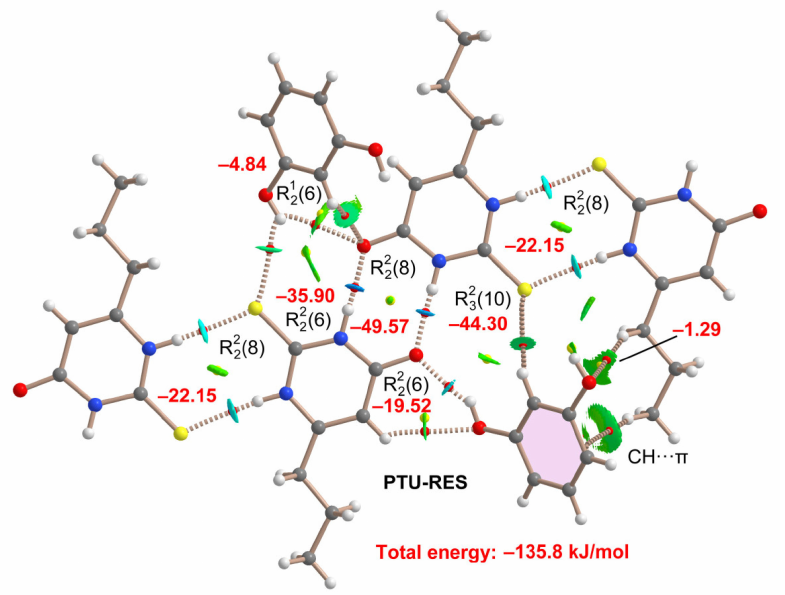
Figure 13. QTAIM/NCIPlot analysis of intermolecular bond and ring CPs (red and yellow spheres, respectively), bond paths, and RDG isosurfaces of the H-bonded assembly of PTU–RES cocrystal. The individual association energies of each synthon or CH ··· O H-bonds are indicated using a red font inside the supramolecular rings or adjacent to the CH ··· O